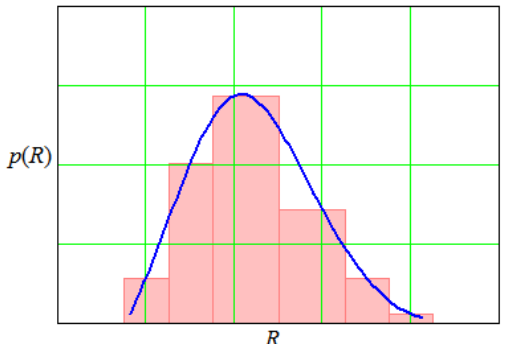
Figure 2. The distribution density of dispersed